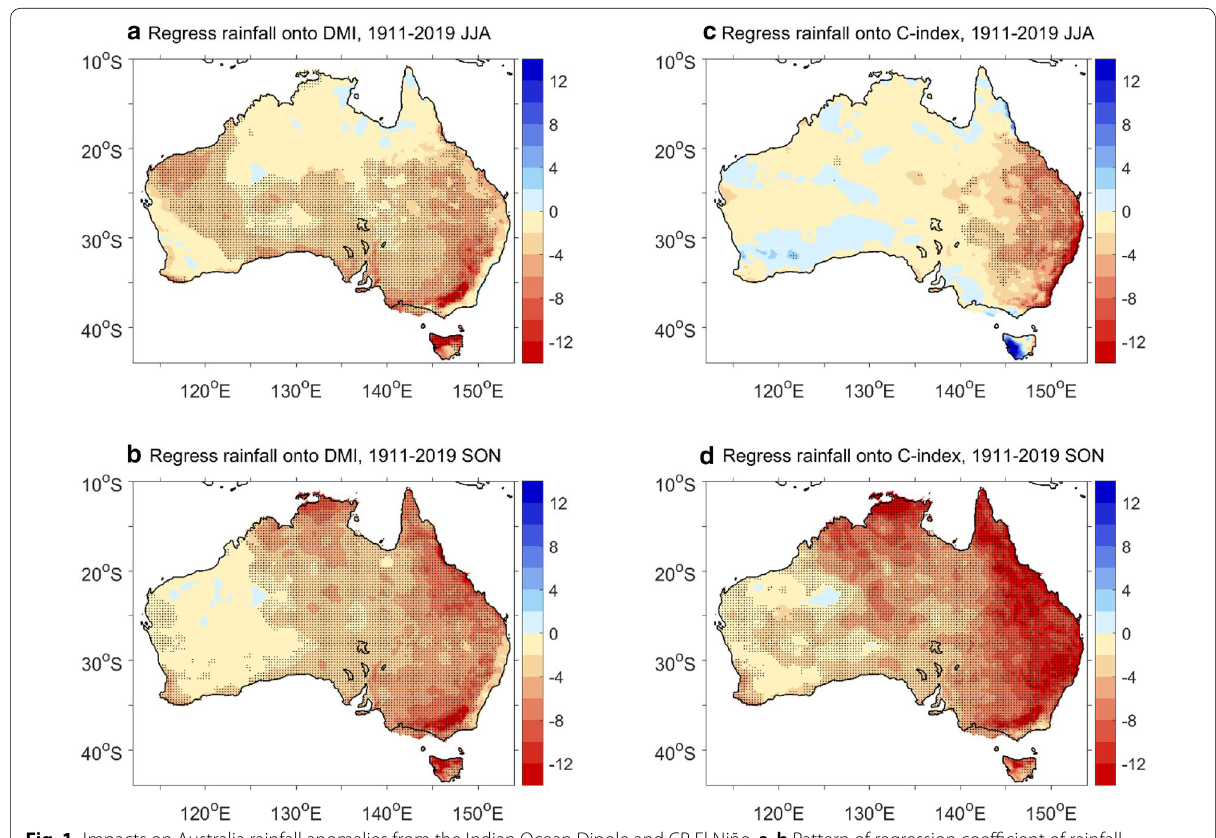
Fig. 1 Impacts on Australia rainfall anomalies from the Indian Ocean Dipole and CP El Niño. a , b Pattern of regression coefficient of rainfall anomalies (mm per month) associated with the DMI over JJA and SON, respectively. c , d The same as a and b but for pattern of regression coefficient associated with C-index. Dotted area indicates corresponding correlation coefficients significant at the 95% confidence level based on a Student t -test. Data are quadratically detrended before